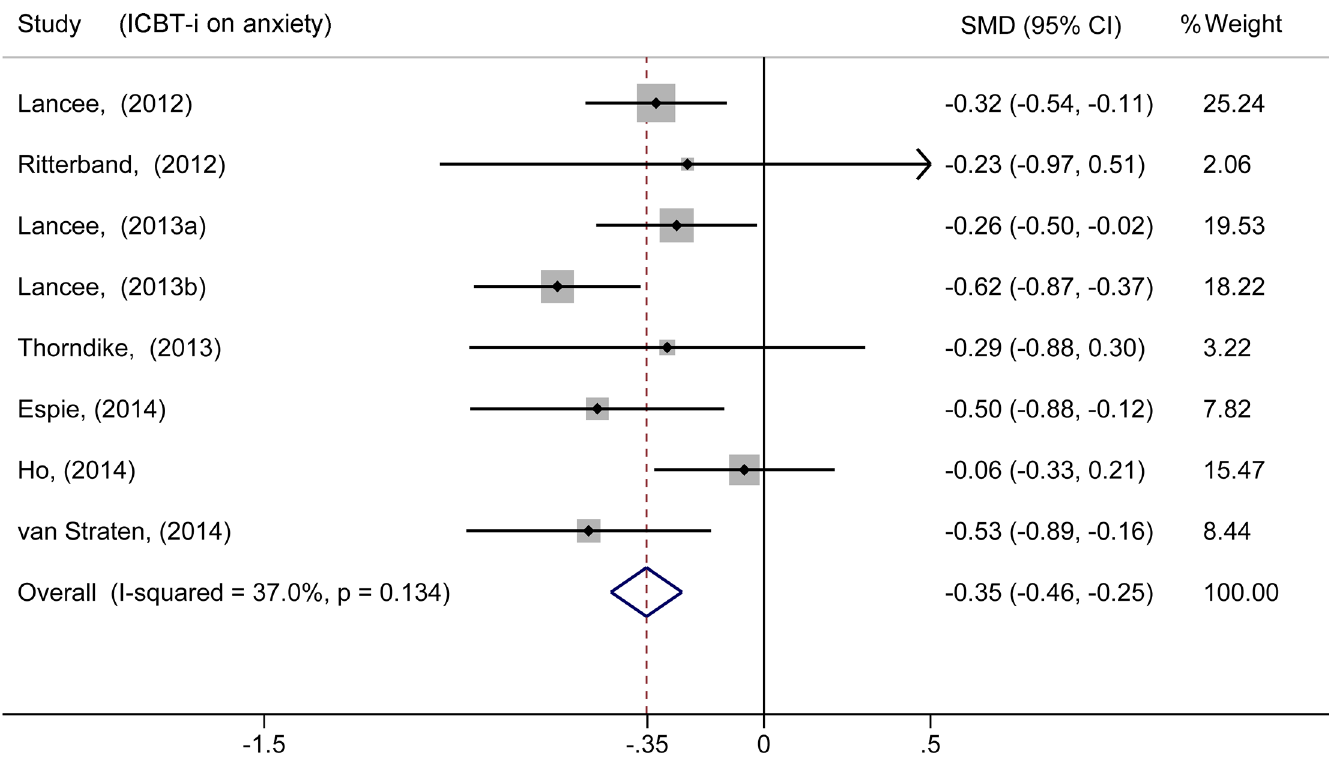
Fig 2. Meta-analysis of the effect of ICBT-i on